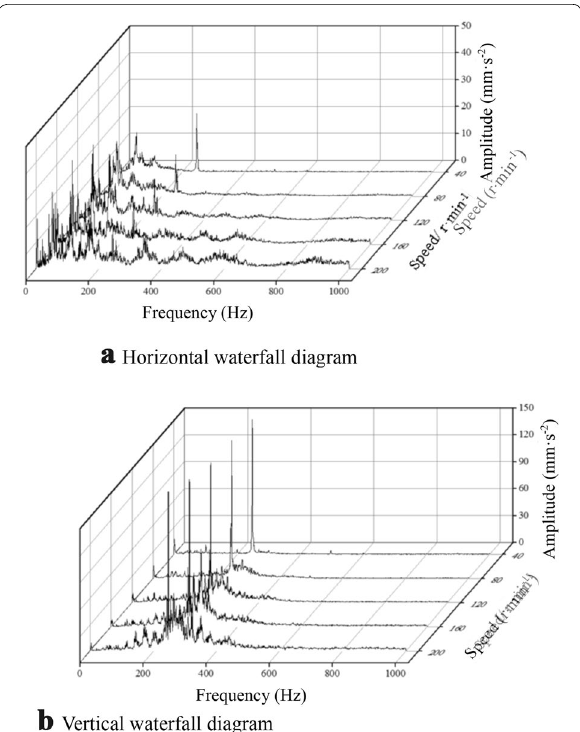
Figure 10 Variation of vibration amplitude of normal bearing. a Horizontal waterfall diagram, b Vertical waterfall